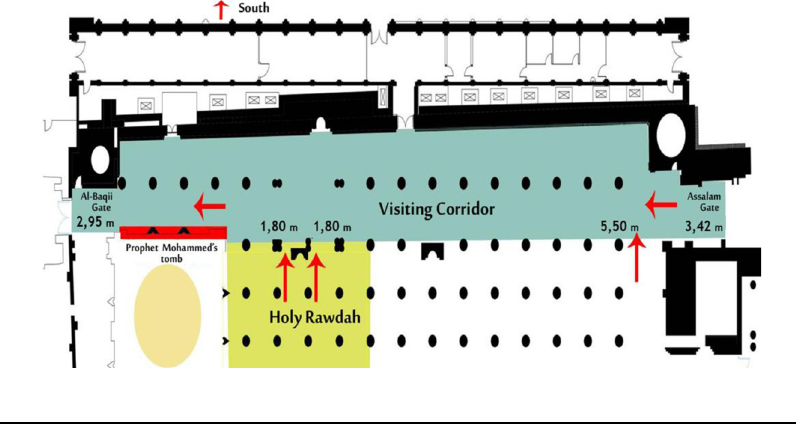
Figure 1. Layout of the study